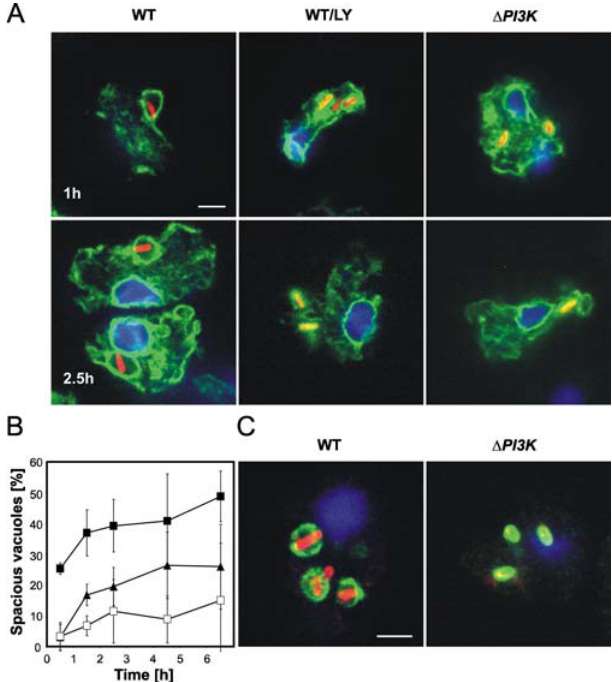
Figure 4. Trafficking of L. pneumophila within Dictyostelium Lacking Functional PI3Ks (A) Confocal laser scanning micrographs of calnexin-GFP–labeled Dictyostelium (green) wild-type Ax3 (WT denotes untreated or treated with 20 l M LY) or D PI3K1/2 (denoted by D PI3K) infected with DsRed- Express–labeled wild-type L. pneumophila (red) for 1 h or 2.5 h, respectively. Representative examples of spacious vacuoles (WT) and tight vacuoles (WT/LY, D PI3K) are shown. DNA was stained with DAPI (blue). Bar denotes 2 l m. (B) Quantification over time of spacious LCVs in calnexin-GFP–labeled Dictyostelium wild-type (filled squares denote untreated; filled triangles denote LY) or D PI3K1/2 (open squares) infected with DsRed-Express– labeled wild-type L. pneumophila. Data represent means and standard deviations of the percentage of spacious vacuoles from 50–200 total vacuoles per time point scored in four independent experiments. (C) Confocal laser scanning micrographs of Dictyostelium wild-type or D PI3K1/2 , infected for 75 min with wild-type L. pneumophila expressing M45-tagged SidC. Infected amoebae were stained with rhodamine- conjugated anti- L. pneumophila antibody (red), FITC-conjugated anti- M45-tagantibody(green),andDAPI(blue),respectively.Bardenotes2 l m. DOI: 10.1371/journal.ppat.0020046.g004